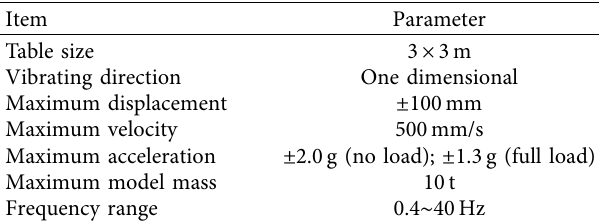
Figure 3: Input seismic loading sequence: (a) El Centro wave; (b) Taft wave; (c) artificial seismic wave. Table 5: Characteristics of the shaking table.